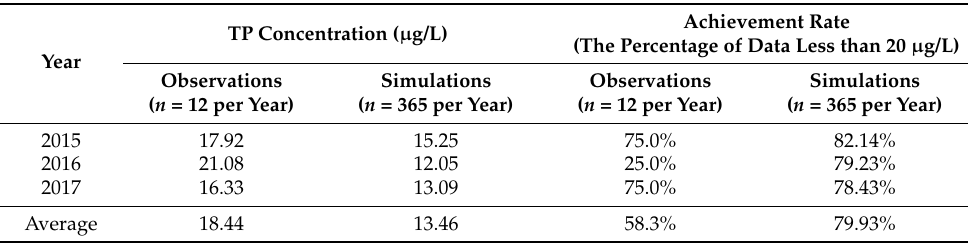
Table 2. Comparison of the observed and simulated average TP concentrations and the achievement rate from 2015 to